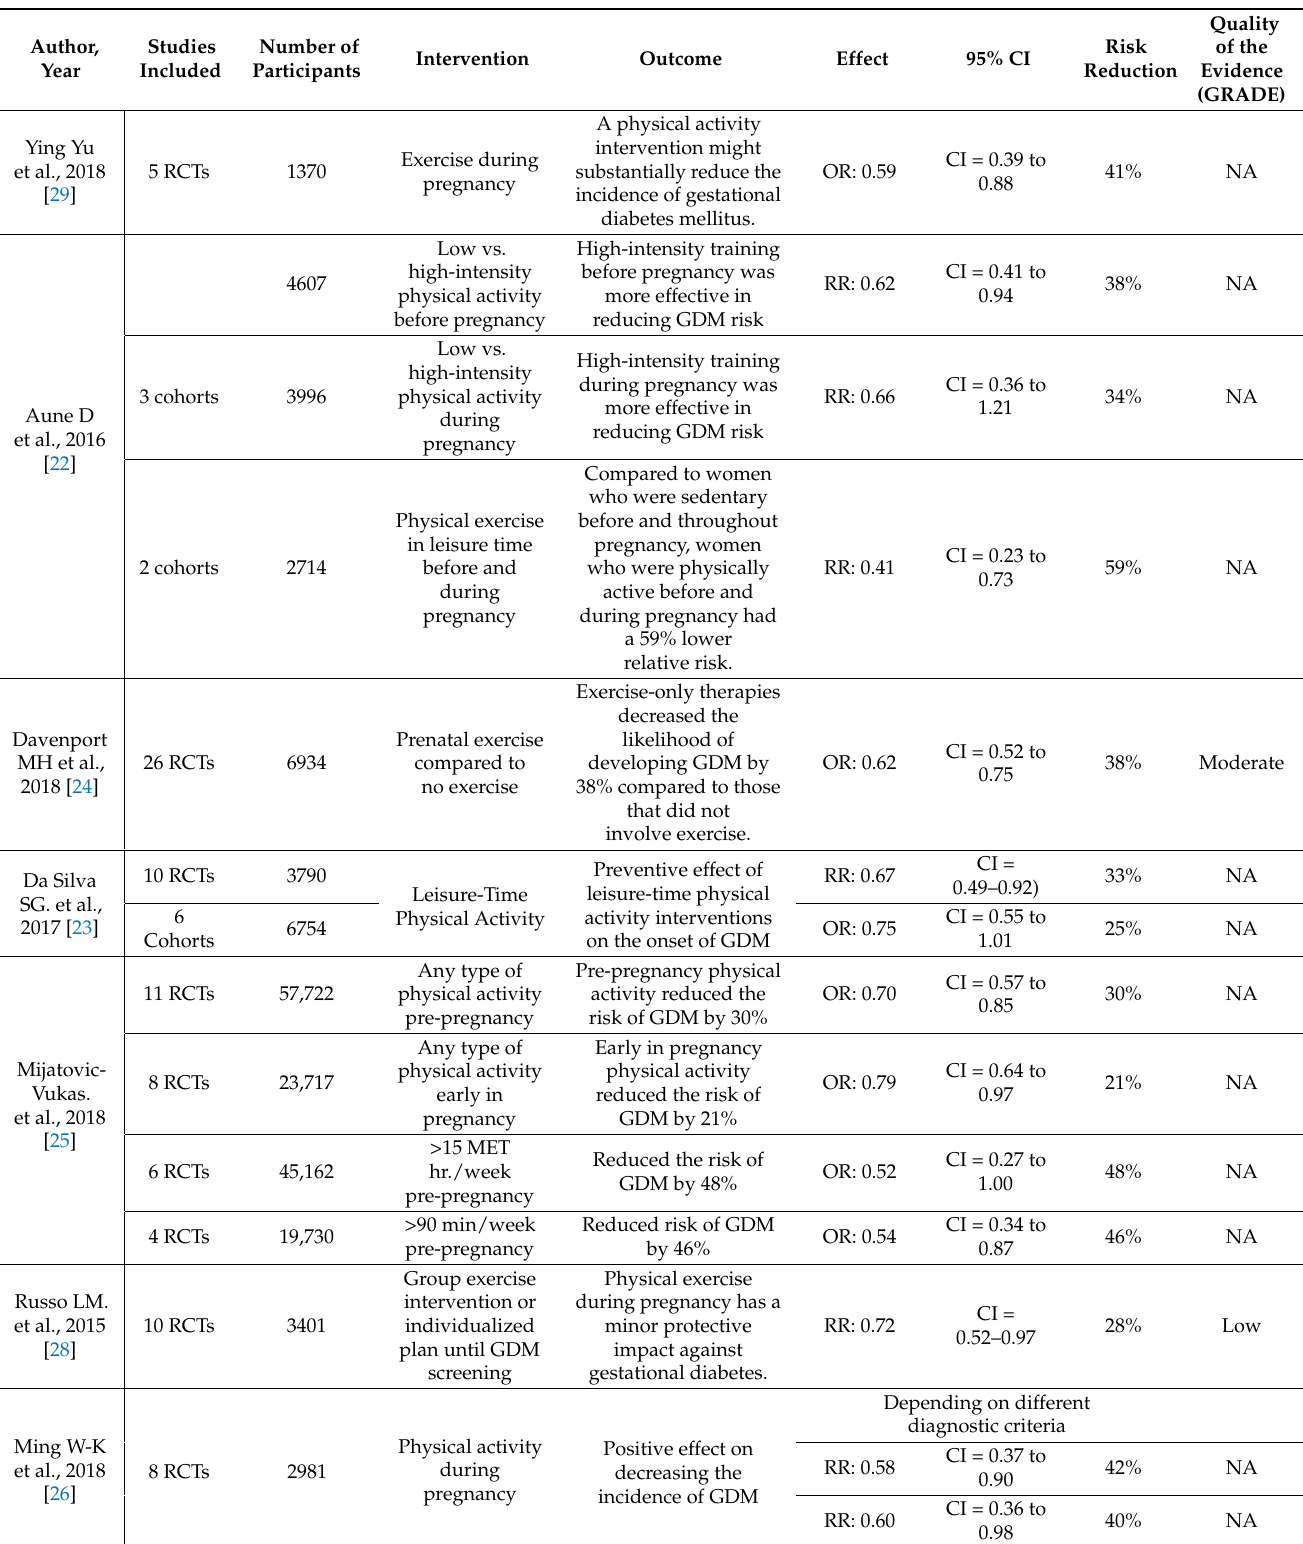
Table 1. Findings of meta-analyses measuring the effect of physical activity on the risk of